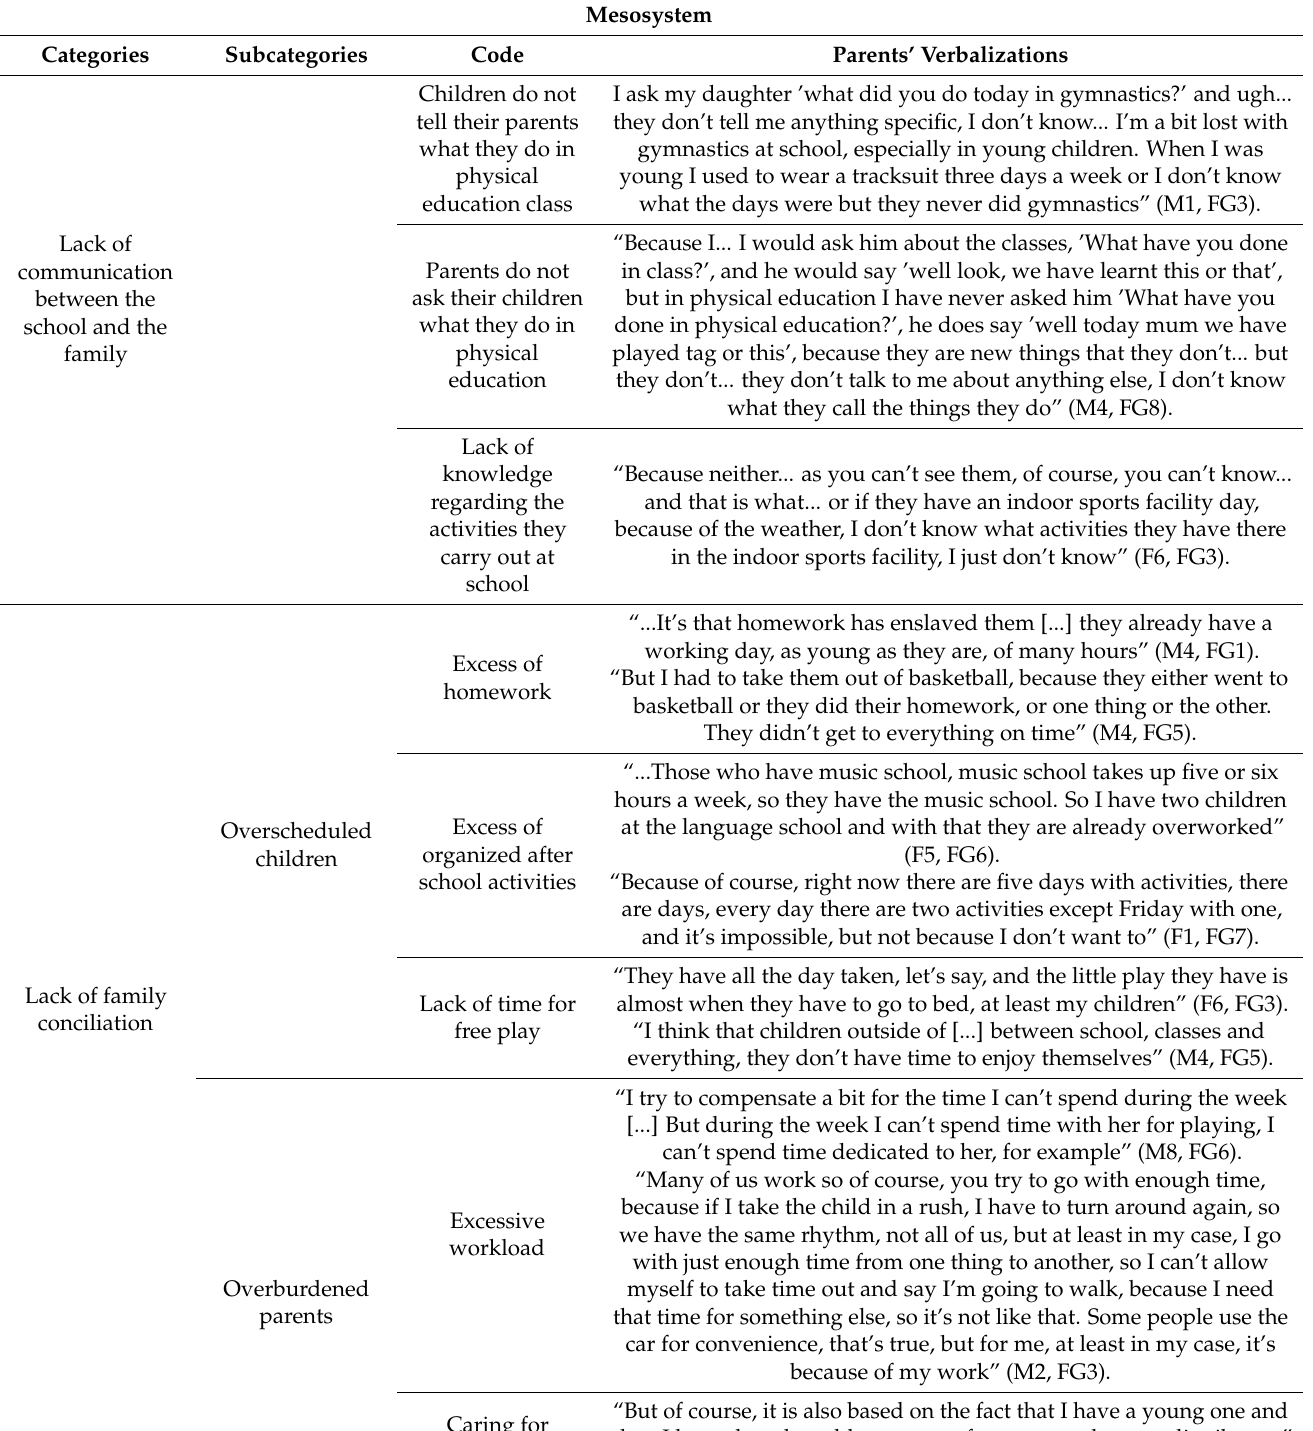
Table 5. Mesosystem barriers to physical activity for